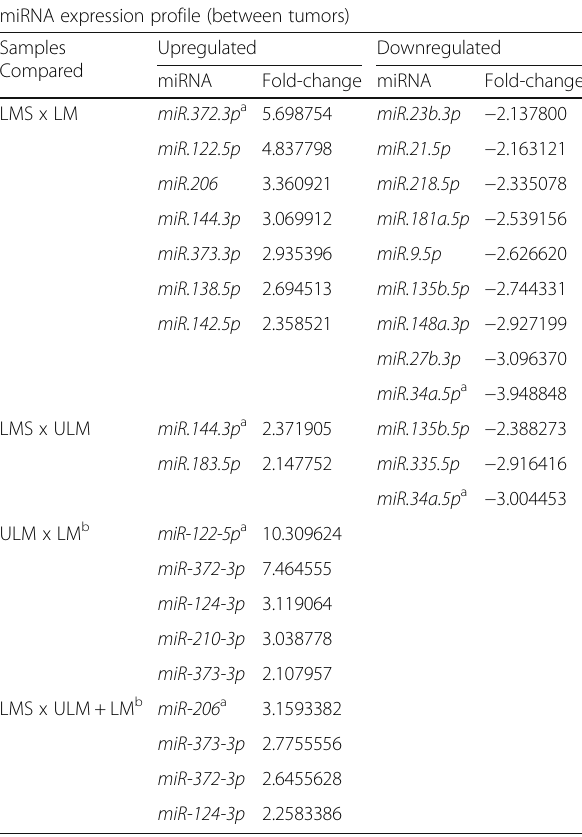
Table 1 Comparison of differentially expressed miRNAs among the tumor types examined miRNA expression profile (between tumors) Samples